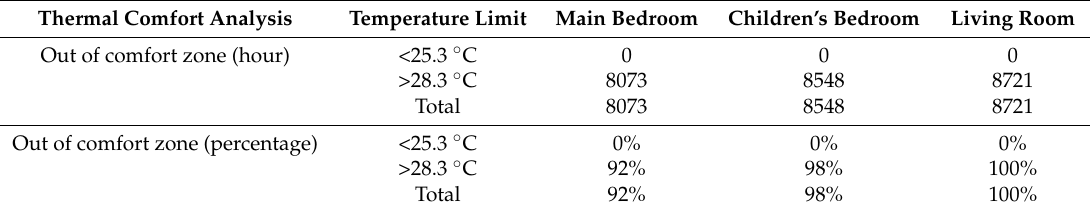
Table 18. Number of discomfort hours in typical house in Indonesia within a